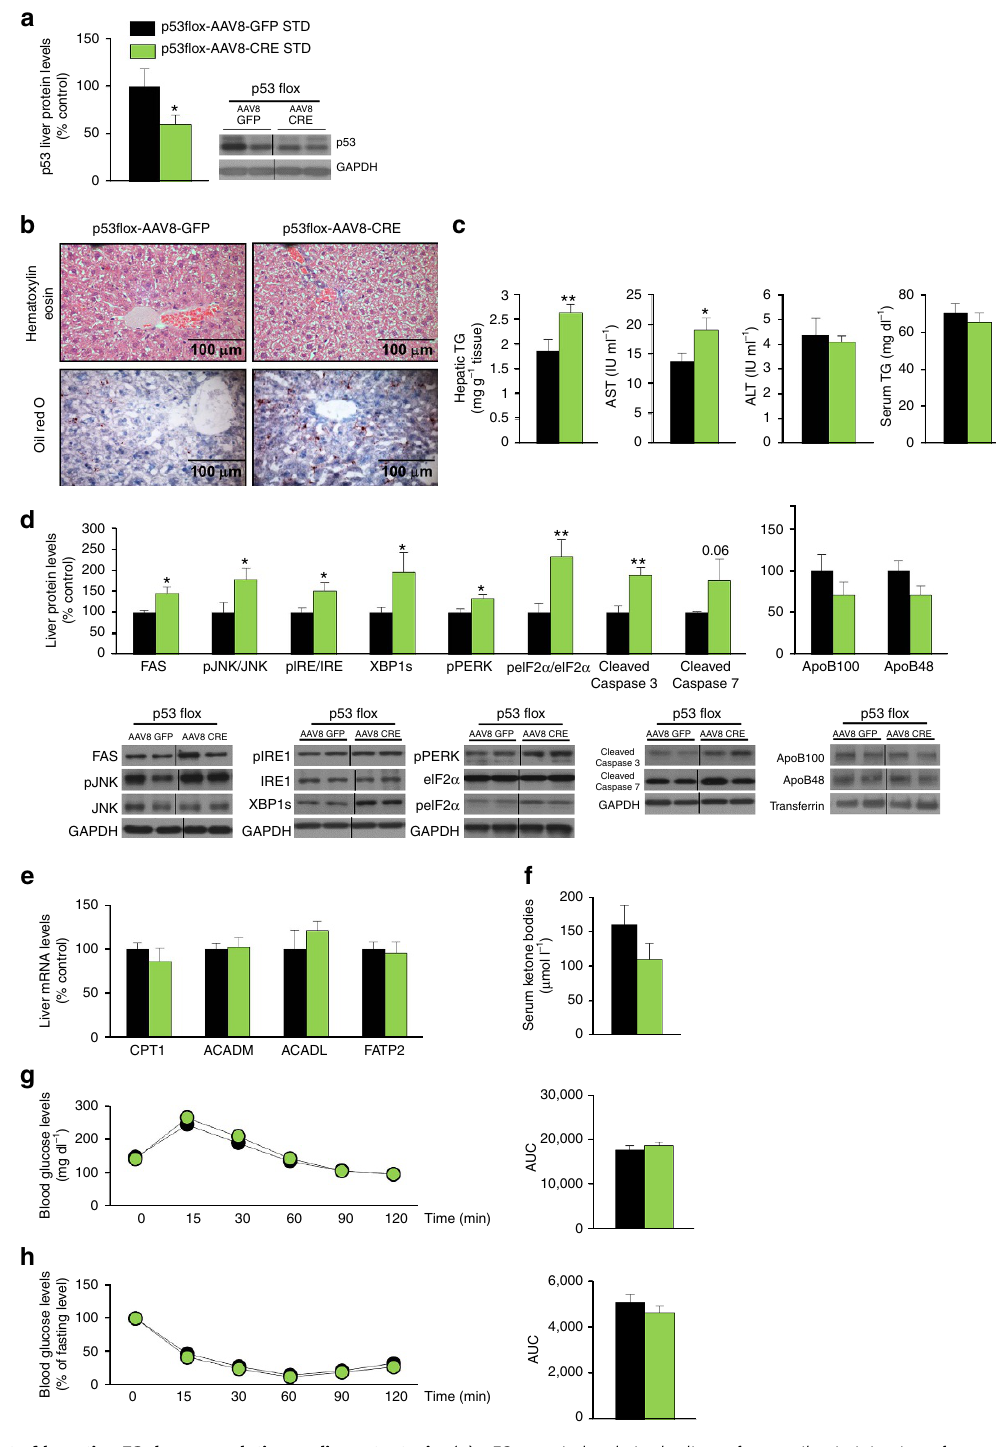
Figure 1 | Effect of hepatic p53 down-regulation on liver steatosis. ( a ) p53 protein levels in the liver after a tail vein injection of an associate adenovirus serotype 8 (AAV8) expressing either GFP or Cre in p53floxed mice fed a standard diet (STD) ( n ¼ 7 per group). Effects of the liver-specific silencing of p53 on ( b ) in hematoxylin-eosin (upper panel) and oil red O staining (lower panel) of mice liver sections ( n ¼ 3 per group); ( c ) total liver TG content, serum AST, ALT and TG levels ( n ¼ 8 AAV8-GFP and 10 AAV8-Cre mice); ( d ) liver protein levels of FAS, pJNK/JNK, pIRE/IRE, XBP1s, pPERK, peIF2 a /eIF2 a , cleaved caspase 3, cleaved caspase 7, ApoB100 and ApoB48; ( e ) mRNA expression of CPT1, ACADM, ACADL and FATP2; ( f ) serum ketone bodies; ( g ) glucose and ( h ) insulin tolerance test ( n ¼ 8 AAV8-GFP and 10 AAV8-Cre mice). The values of AAV8 GFP mice were always normalized to 100% ( n ¼ 7 per group). Protein GAPDH or transferrin levels were used to normalize protein levels. Dividing lines indicate splicings in the same gel. Uncropped blots of this Figure accompanied by the location of molecular weight markers are shown in Supplementary Fig. 10. Data are presented as mean ± standard error mean (s.e.m.). Statistical significance, * P o 0.05 and ** P o 0.01, was tested using Student t -test comparing AAV8-GFP and AAV8-Cre mice.